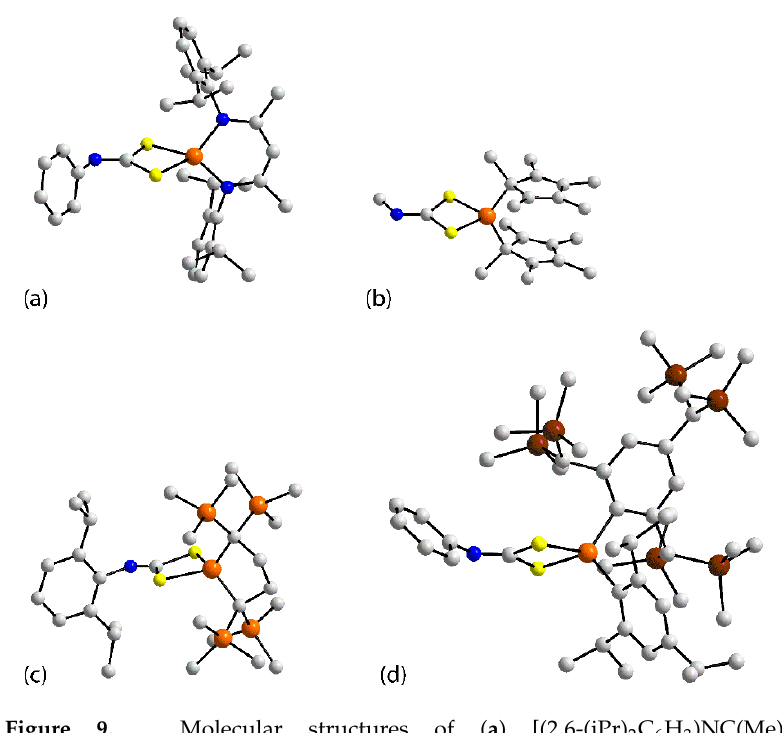
Figure 9. Molecular structures of ( a ) [(2,6-(iPr) 2 C 6 H 3 )NC(Me)=C(H)C(Me)=N(2,6-(iPr) 2 C 6 H 3 )]Ga[S 2 C=N(Ph)] in 40 , ( b ) (C 5 Me 5 -C) 2 Si[S 2 C=N(Me)] ( 41 ), ( c ) [(Me 3 Si) 2 CCH 2 CH 2 C(SiMe 3 ) 2 -C,C]Si[S 2 C=N(2,6-(iPr) 2 C 6 H 3 )] ( 42 ), and ( d ) {2,4,6-[C(H)(SiMe 3 ) 2 ] 3 C 6 H 2 }[(2,4,6-iPr) 3 C 6 H 2 ]Ge[S 2 C=N(Ph)] ( 43 ).